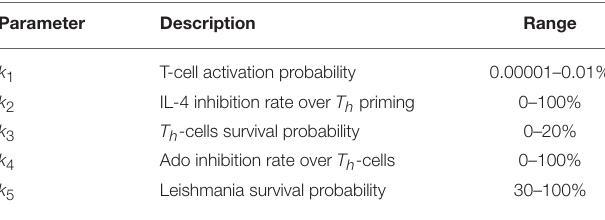
TABLE 2 | Range of values tested in LHS-PRCC (latin hypercube sampling-partial ranking correlation coefficient in the sensitivity analysis). Parameter